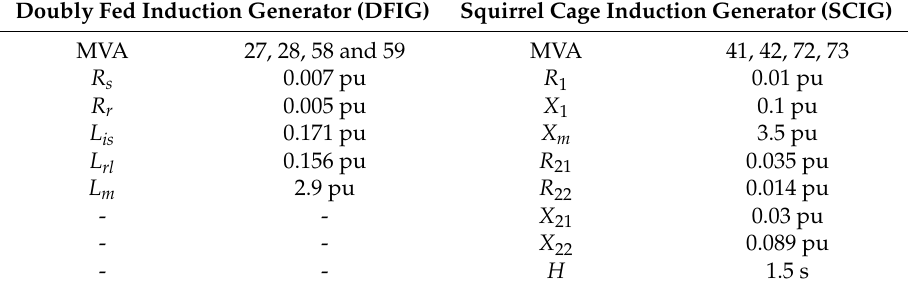
Table 5. Parameters of wind generators.